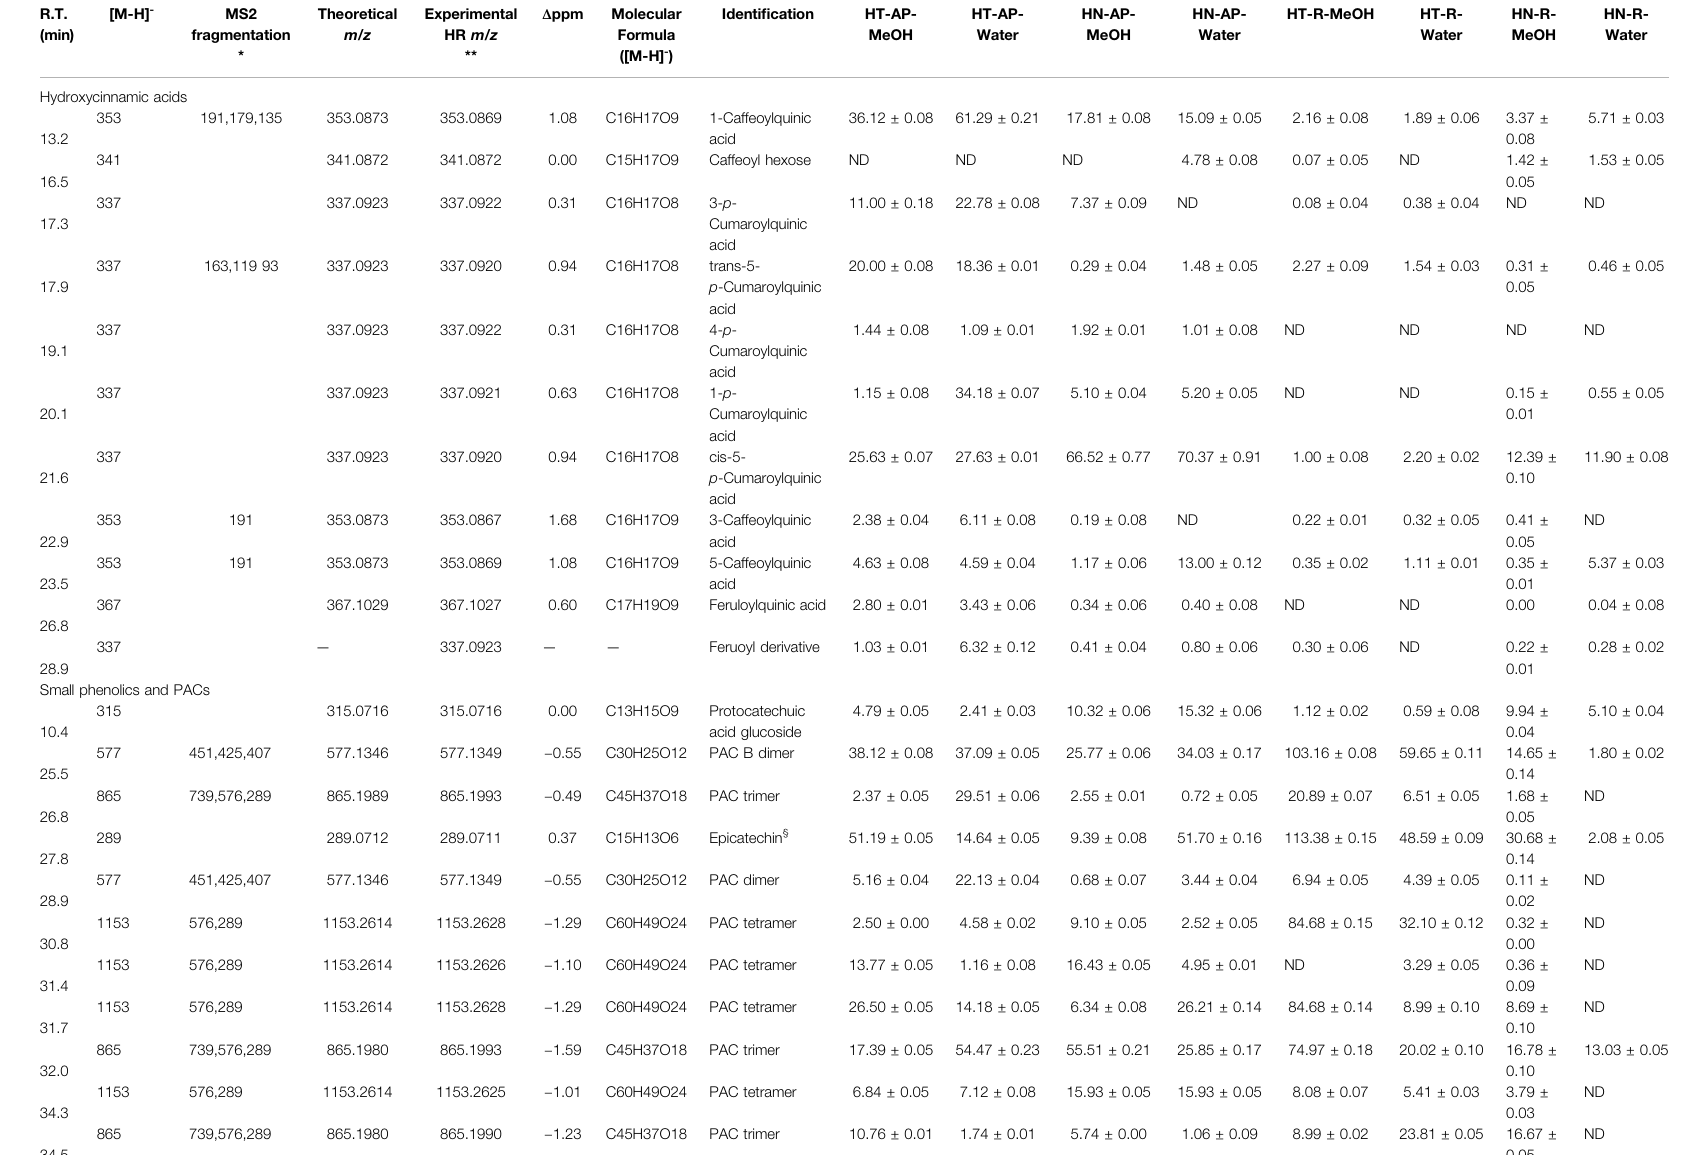
TABLE 2 | LC-DAD-MS n and LC-QTOF data used for the identi fi cation of phenolic constituents in Hypericum triquetrifolium and Hypericum neurocalycinum methanol and water extracts of both aerial parts and roots. Quantitative data of all the extracts are also reported. R.T.